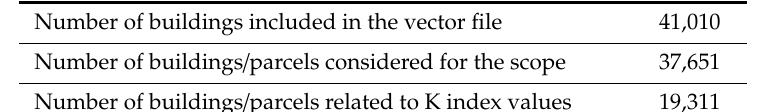
Figure 3. K index map at cadastral parcel scale. Bing aerial imagery is used as the base map.